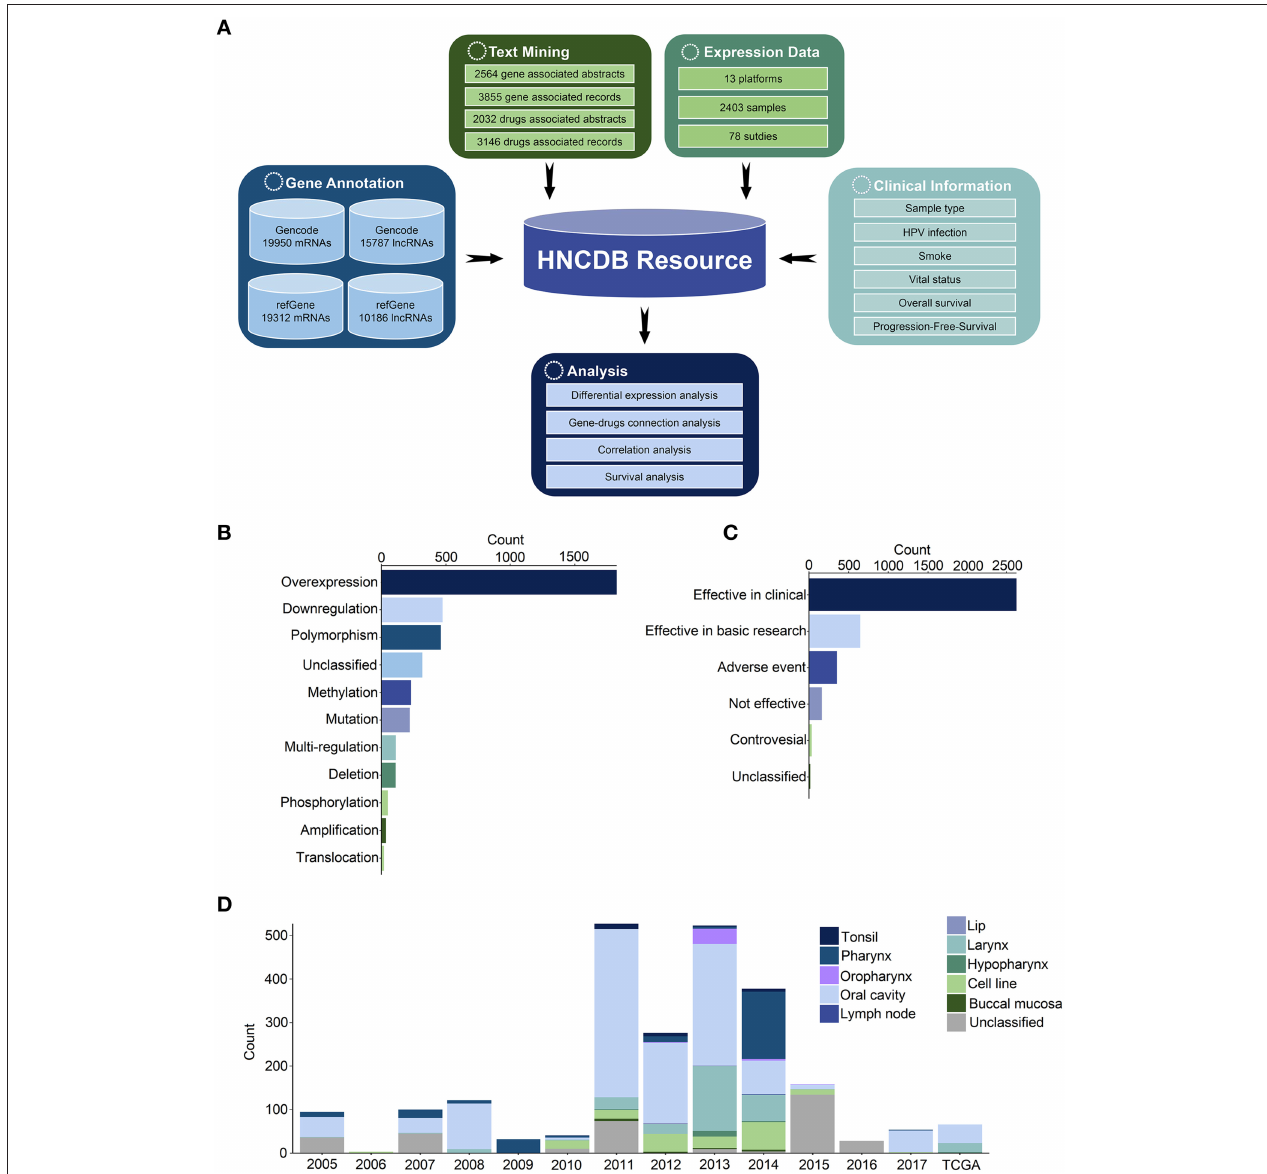
FIGURE 1 | Construction of HNCDB. (A) Flowchart of the database construction process. (B) HNC-related abstracts associated with gene dysregulation in HNC. (C) HNC-related abstracts associated with drug efficacy in HNC. (D) Summary of the HNC gene expression dataset in HNCDB.